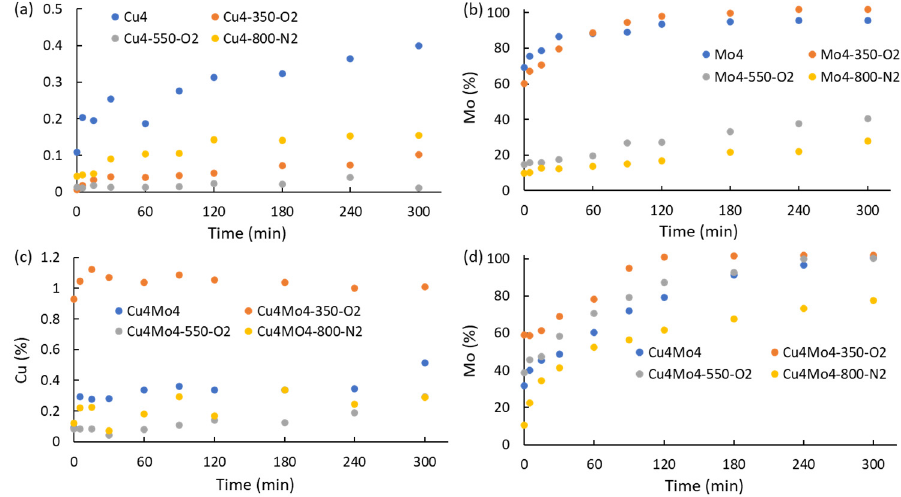
Figure 10. Kinetics of Cu and Mo lixiviation from catalysts under artificial solar irradiation. ( a ) Cu series; ( b ) Mo series; ( c ) Cu in CuMo series; ( d ) Mo in CuMo series. Table 7. Summary of the kinetics results of Cu and Mo detected in dark and irradiation conditions relative to nominal contents of elements listed in Table 5.